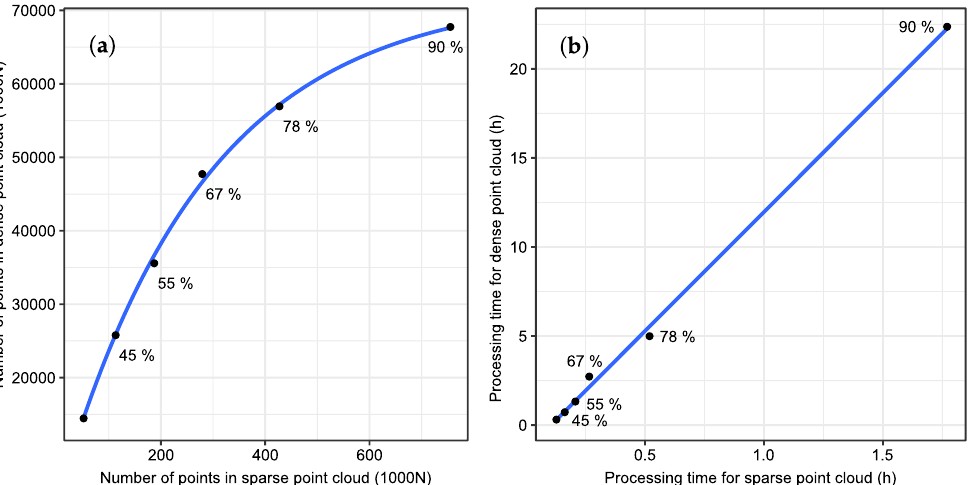
Figure 4. Relationship between sparse reconstruction and dense reconstruction with regards to ( a ) point numbers and ( b ) processing times. The percent numbers indicate the side overlap that was used to vary the tie point numbers in the sparse point cloud. Equation and regression coefficients in Supplementary Table S1.